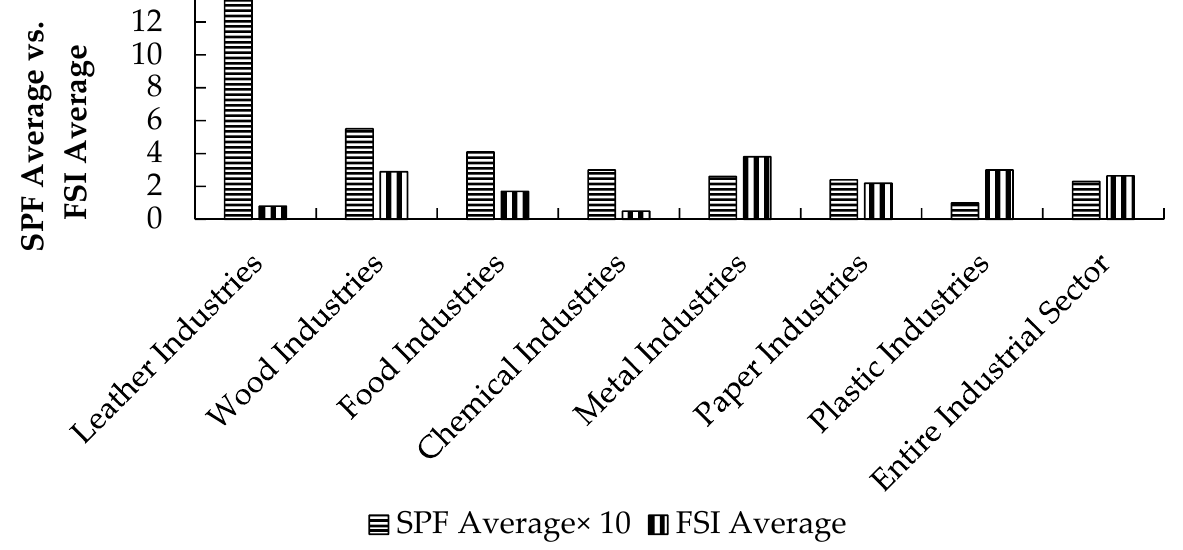
Figure 19. Severity classification of the Palestinian industrial sectors according to SPF and FSI indicators.